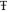
Pre-pulse Inhibition (PPI). Prepulse inhibition at different inter-stimulus interval and pulse intensity. (A) 30_75. (B) 30_85. (C) 100_75. (D) 100_85, respectively. All data presented here are presented as mean ± SEM, where a* as compared to control at p ≤ 0.001; a# as compared to control at p ≤ 0.05; a as compared to control at p ≤ 0.01 and b with above symbols shows comparison of groups with DISC1 mutation animals.